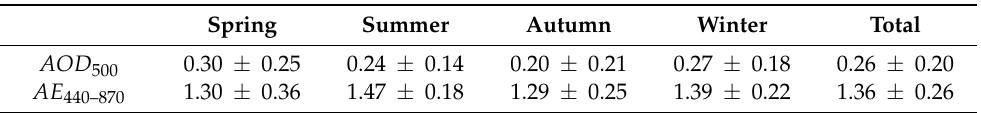
Table 1. Seasonal variations in aerosol optical depth at 500 nm and Angstrom exponents at 440–870 nm during the study